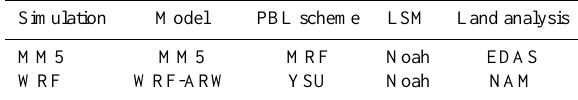
Table 4. Model simulation